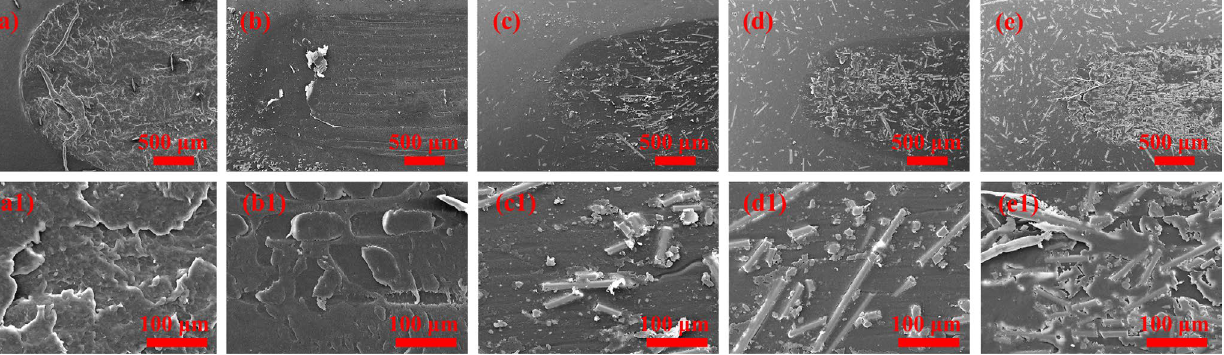
Figure 8. SEM micrographs of ( a ) neat PA 6, ( b ) PA 6/SEBS blend, ( c ) PA 6/SEBS/BF5, ( d ) PA 6/SEBS/BF10, and ( e ) PA 6/SEBS/BF20 ; ( a1 – e1 ) corresponding magnified SEM micrographs for neat PA 6 to PA 6/SEBS/BF20 .